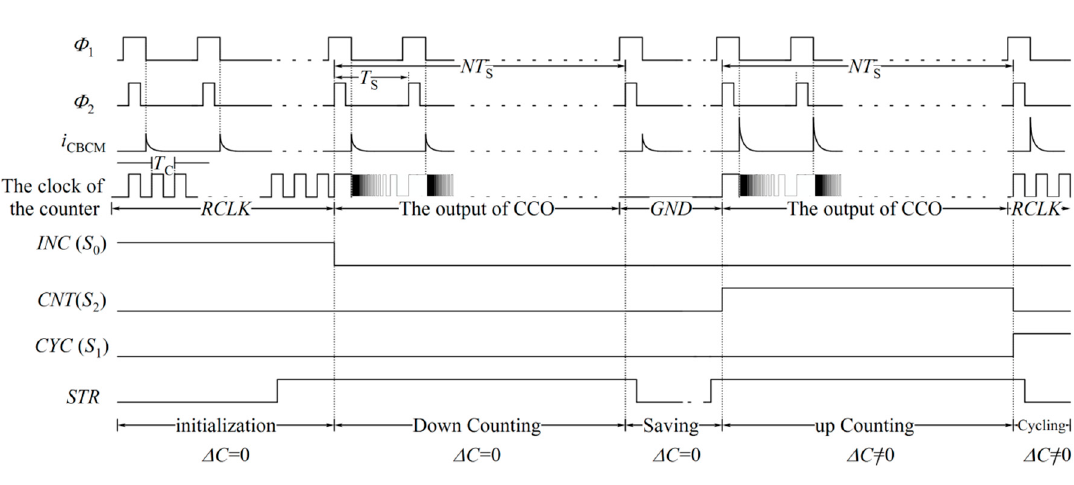
Figure 13. Model of interdigitated electrodes.